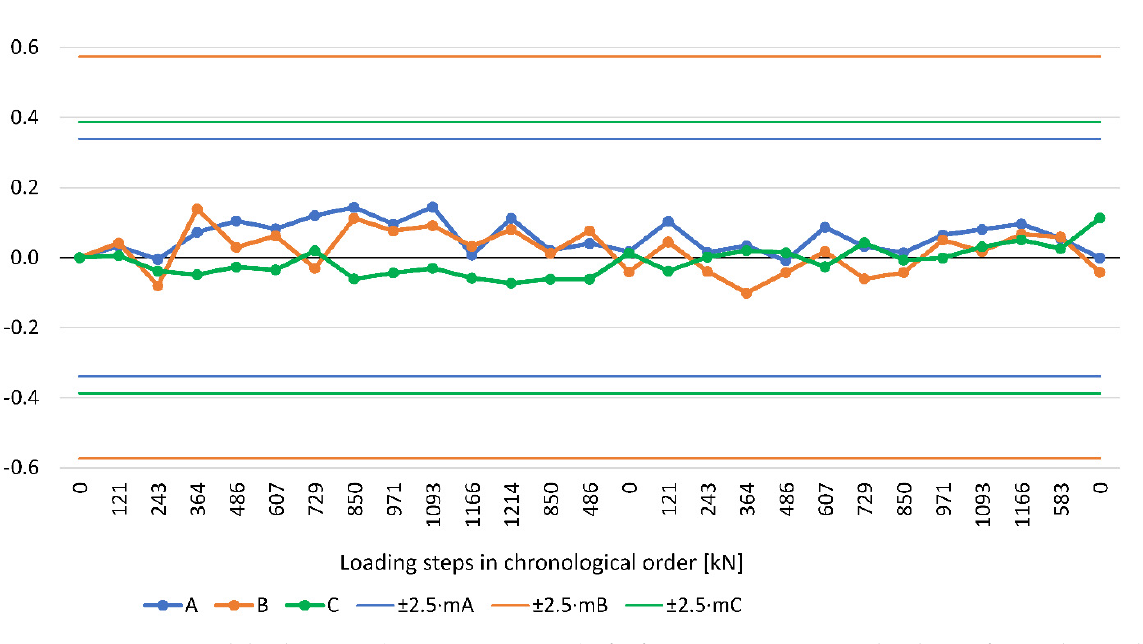
Figure 8. “Apparent” vertical displacement (measurement noise) of reference points: A, B, and C during first and second loading cycles with an acceptable range of ± 2.5 · mA, ± 2.5 · mB, and ± 2.5 · mC (two and a half times the mean error of vertical displacement determination for each reference